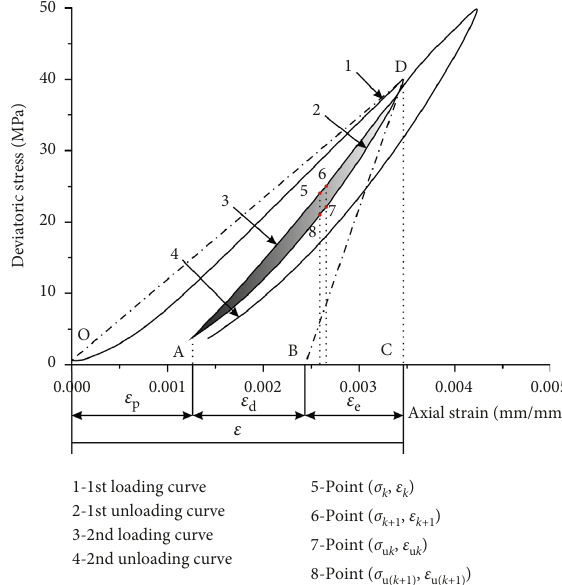
Figure 2: Typical hysteresis loop curve of the cyclic loading- unloading test for the rock specimen.